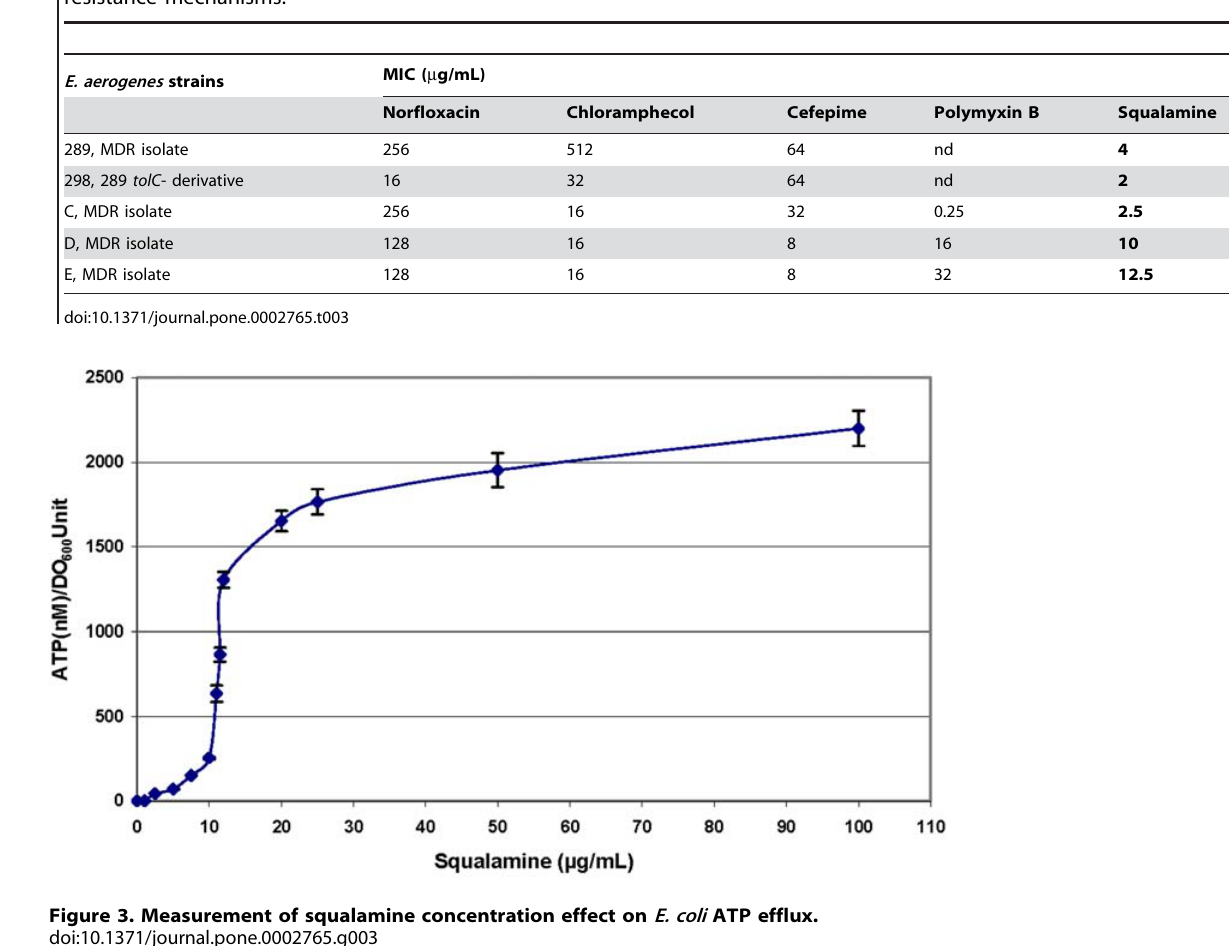
Table 3. Antibacterial susceptibility of various Multidrug resistant (MDR) E. aerogenes clinical isolates expressing various antibiotic resistance mechanisms.